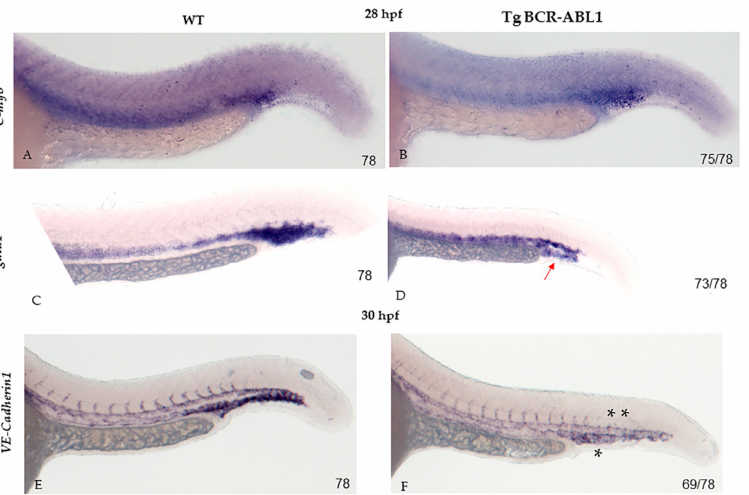
Figure 5. Transcriptional changes of erythropoiesis markers. Whole mount in situ hybridization (WISH) at 28 hpf of c-myb ( A , B ), gata1 ( C , D ); VE-cadherin ( E , F ) in wild type (WT) and Tg BCR-ABL1 fish, respectively. The experiments were performed in duplicate; numbers in each panel represent total embryos used for the experiment and embryos with the result shown in the image. Red arrow in ( D ) indicate the downregulated expression level of gata1 in caudal plexus in Tg BCR-ABL1 fish; ( F ) single black asterisk indicate the downregulated expression level of VE-cadherin in caudal plexus in Tg BCR-ABL1 fish; double black asterisks indicate the not well-formed nascent vessels in Tg BCR-ABL1